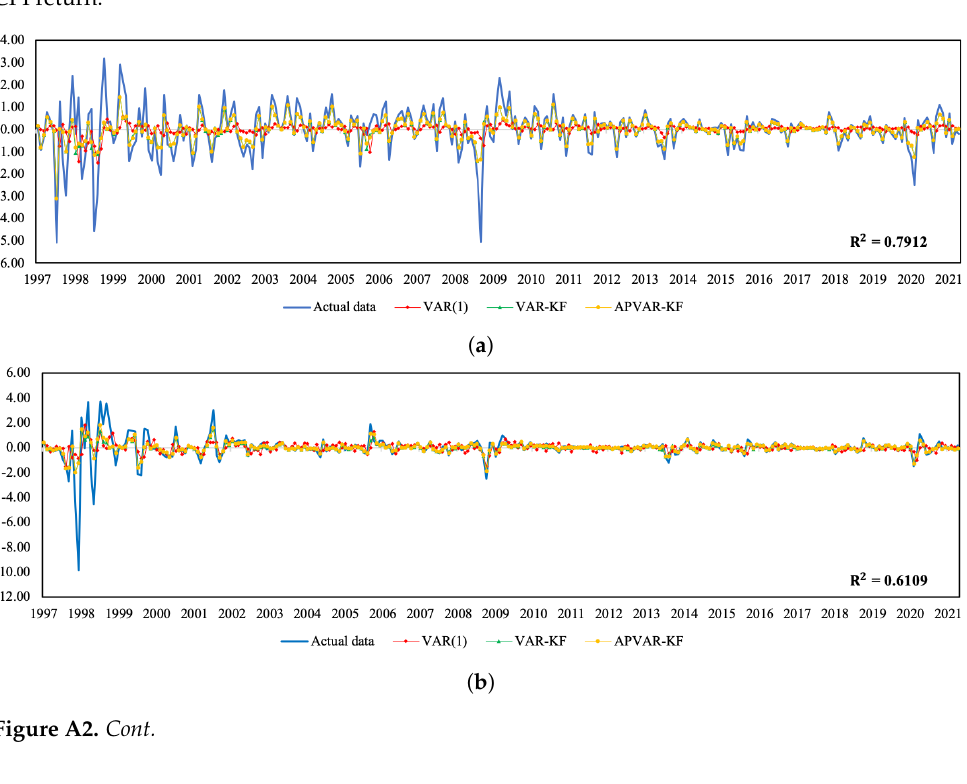
Figure A1. Plots of the actual data and the estimated values from three methods for Thailand. ( a ) Normalized SET index return; ( b ) normalized real effective exchange rate return; ( c ) normalized CPI return.